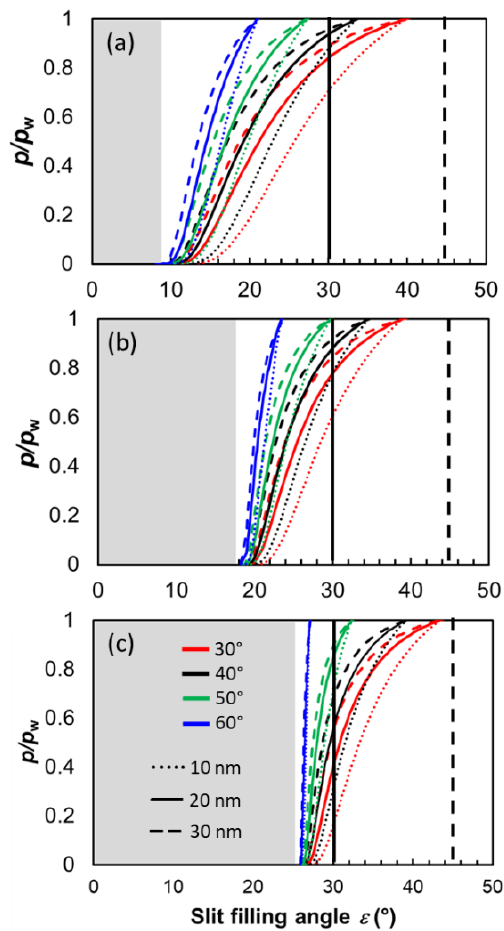
Figure B4. Saturation ratio with respect to water ( S w = p/p w ) re- quired for filling of three-membered and four-membered ring pores as a function of slit-filling angle ε at T = 220K for (a) C ov = 0 . 01, (b) C ov = 0 . 05, and (c) C ov = 0 . 1. Primary particle diame- ters D pp = 10–30nm and soot–water contact angles θ sw = 30–60 ◦ are shown as indicated in the legend. For a slit filling of ε = 30 ◦ (solid black vertical line) and ε = 45 ◦ (dashed black vertical line), the pendular water rings coalesce resulting in complete filling of the pore opening for the three-membered and four-membered ring pores, respectively. The grey-shaded area indicates the range of overlap between primary particles which extends to ε ov = 8 . 11 ◦ for C ov = 0 . 01, ε ov = 18 . 19 ◦ for C ov = 0 . 05, and ε ov = 25 . 84 ◦ for C ov = 0 .